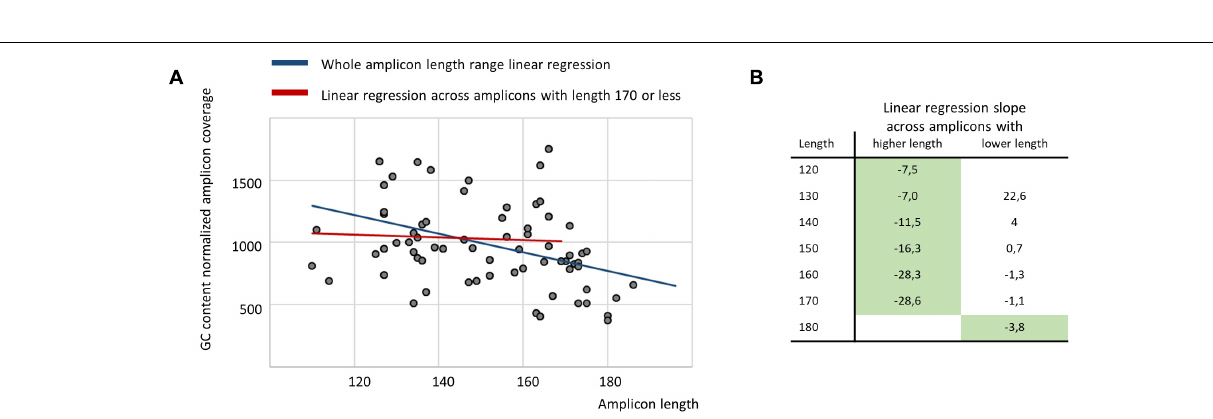
FIGURE 4 | The regression analysis demonstrates no relationship between amplicon length and its average coverage when restricting the analysis to amplicons with a length of 170 or less (A) , while, broken stick regression indicates that the system suffers a shock after 170 bp (B) (green fill indicates statistically significant slope coefficient with p -value of 0.05 or